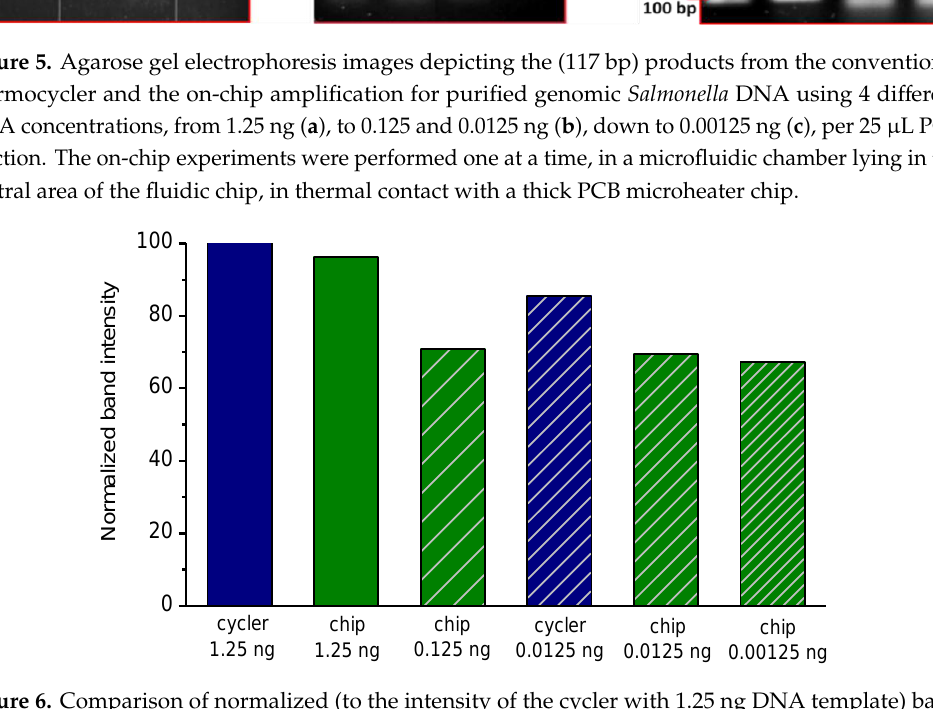
Figure 6. Comparison of normalized (to the intensity of the cycler with 1.25 ng DNA template) band intensities for PCR reactions of di ff erent DNA template amounts in the standard thermocycler (i-cycler) and the static microPCR after 40 cycles of the 2T PCR.